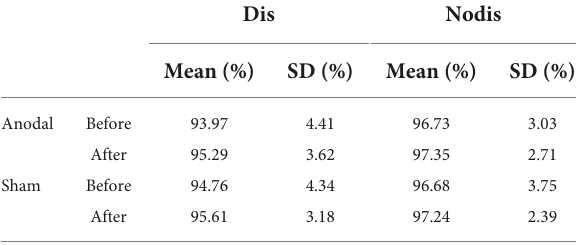
TABLE 1 The percentage of trials included in each